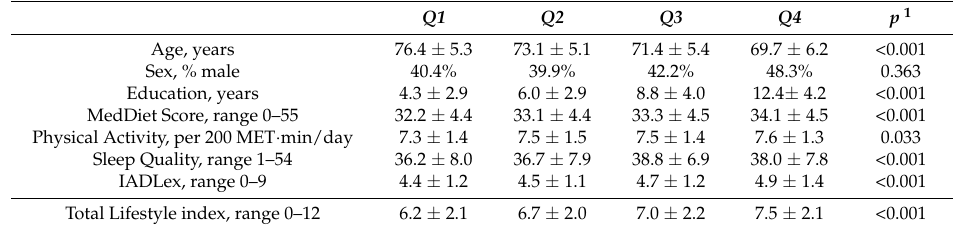
Table 5. Socio-demographic characteristics, lifestyle factors and TLI by quartiles of composite z-score in non-demented, non-MCI participants.